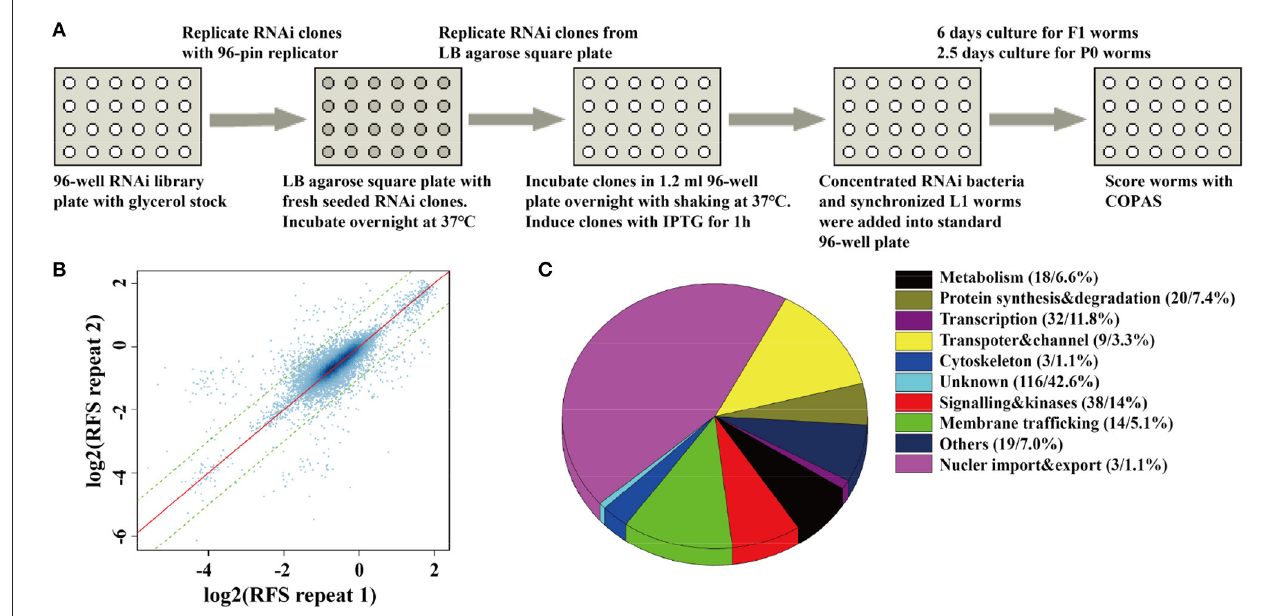
FIGURE 1 | A whole-genome RNAi screen for genes required for synaptic vesicle cycling. (A) A schematic diagram of COPAS-based whole-genome RNAi screen. RNAi experiments for each clone were duplicated for whole genome screen or four replicates for the second validation screen. (B) The reproducibility of the whole genome screen data. The scatter plot shows the reproducibility of two repeats of each RNAi experiment in the whole genome screen. Each point indicates a RNAi experiment. The x axis and y axis are the log2 transformed median RFS (relative fluorescent signal) of the two repeats. The red line y = x indicates 100% repeatability. The two green lines y = x + 1 and y = x − 1 are the fold change of the two repeats are equal to 2. 97.9% of the points fall between the two lines. (C) The percentage distribution chart of candidate genes within indicated functional classes. The total number of genes in each group and its percent to the total number of candidate genes are indicated in the parenthesis. 272 candidate genes were found for synaptic vesicle cycling after multi-round RNAi screen (Tables S2, S3).